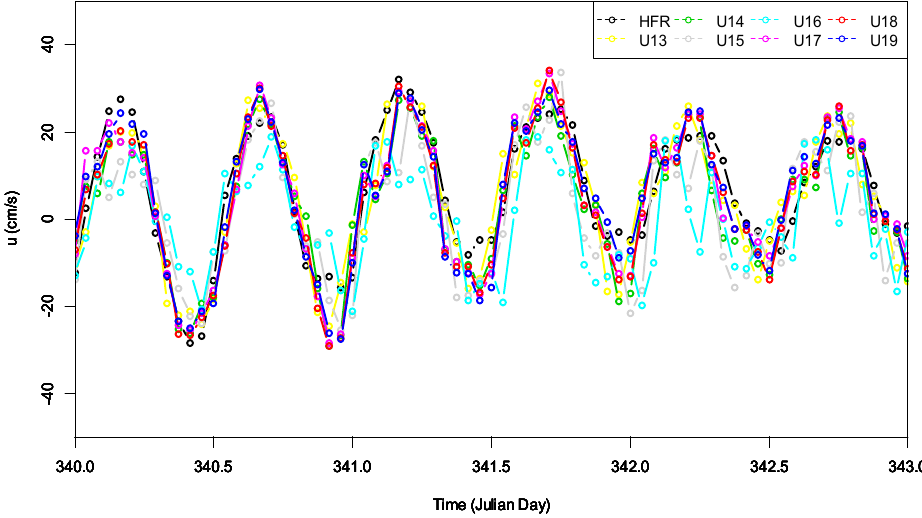
Figure 10. Forecasts of u velocity component at A3.